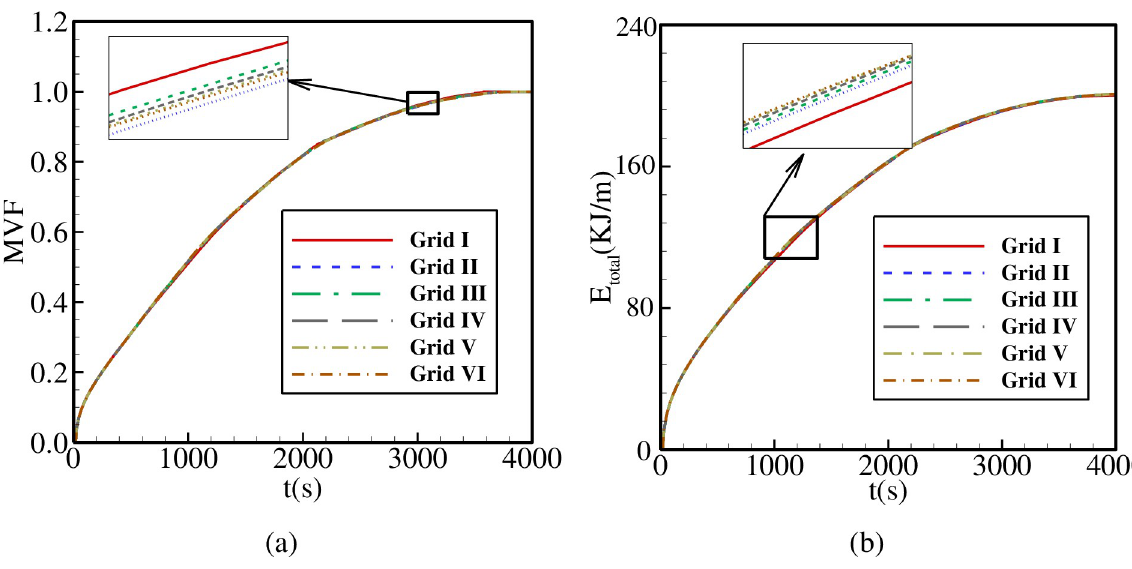
Fig 2. The influence of mesh size on (a): the melt volume fraction (MVF); (b): the total energy stored (E total ). https://doi.org/10.1371/journal.pone.0246972.g002 Figs 2 and 3, variables involved in the mesh-independency test are melting volume fraction, stored energy and melting interface. By investigating the graphs for all cases, it is evident that all cases, especially III, IV, and V, are almost accordant with each other. For efficiency in the